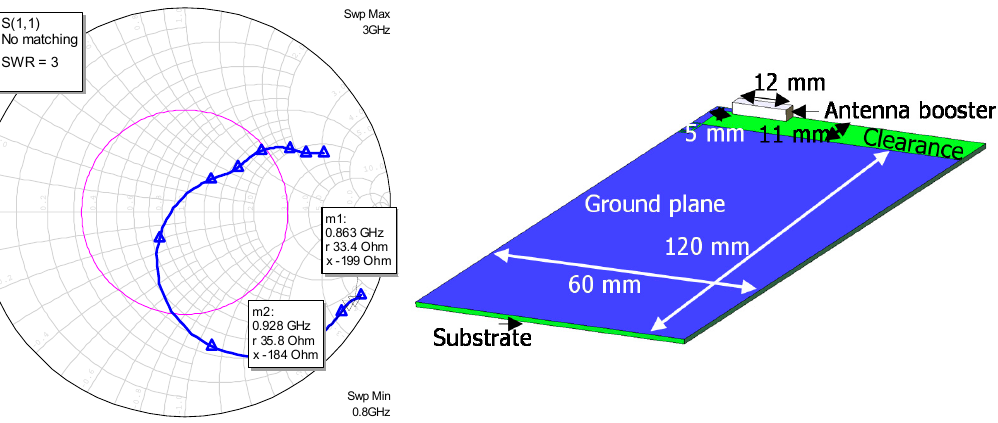
Figure 1. S 11 for a 12 mm × 3 mm × 2.4 mm (height) antenna booster on a 120 mm × 60 mm ground plane without a matching network featuring a reactive impedance. The substrate is 1 mm thick with ε r = 4.15 and tan δ = 0.017. The antenna booster is modeled as a conductive parallelepiped with a conductivity of σ = 5.9×10 7 S/m.